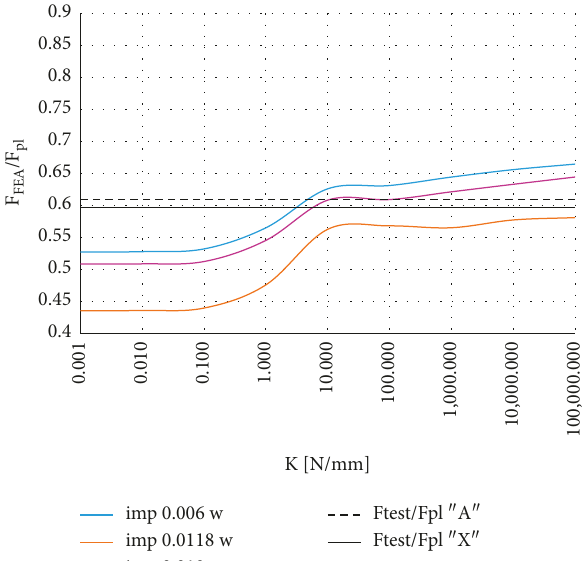
Figure 20: Numerical results for the normalized ultimate load as a function of spring stiffness of the 600mm column.